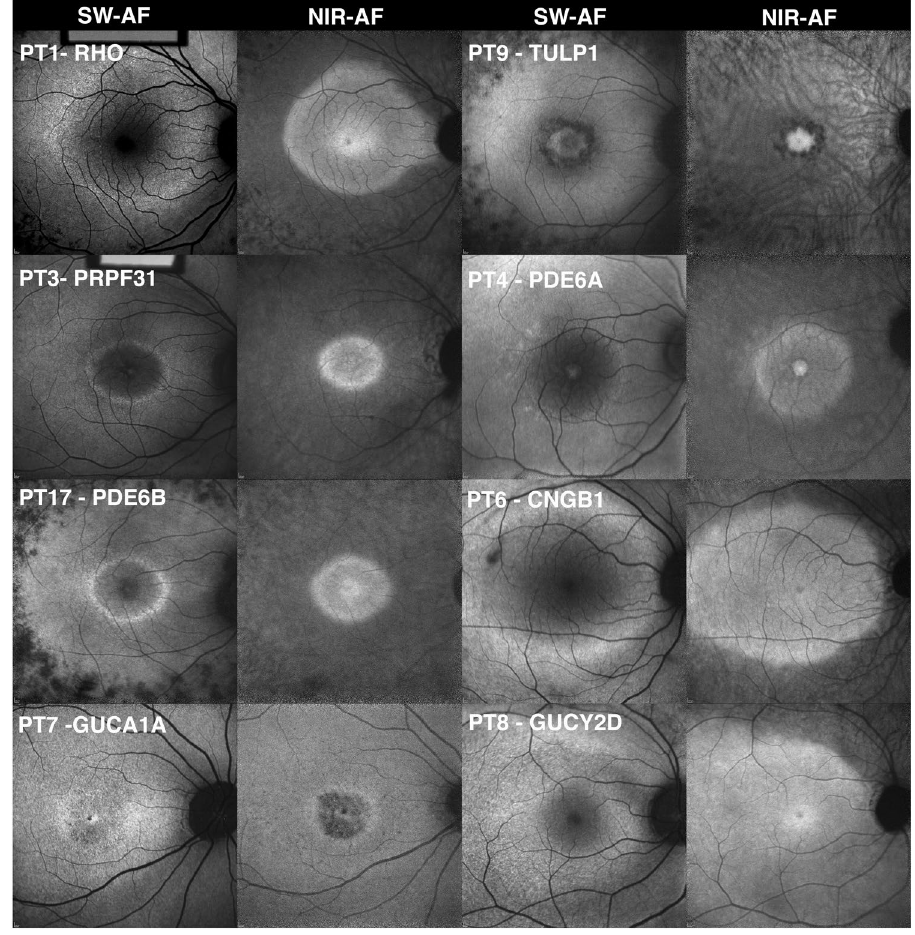
Figure 2. Fundus autofluorescence images obtained from patients with mutations in phototransduction genes (PT). The short-wavelength autofluorescence (SW-AF) and near-infrared autofluorescence (NIR-AF) images obtained from patients with mutations in phototransduction genes ( RHO, PRPF31, PDE6B, GUCA1A, TULP1, PDE6A, CNGB1 , and GUCY2D) , exhibit hyperautofluorescent rings in both SW-AF and NIR-AF images. The exception is the patient with a mutation in GUCY2D , who presents with a sectoral hyperautofluorescent arc in the superior retina. In all cases, autofluorescence was sufficient to enable imaging and the macula appeared brighter than the ophthalmic vessels and the optic